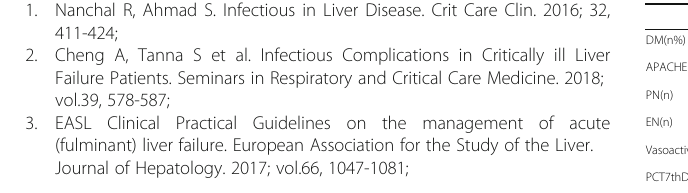
Table 1 (abstract 000453). See text for